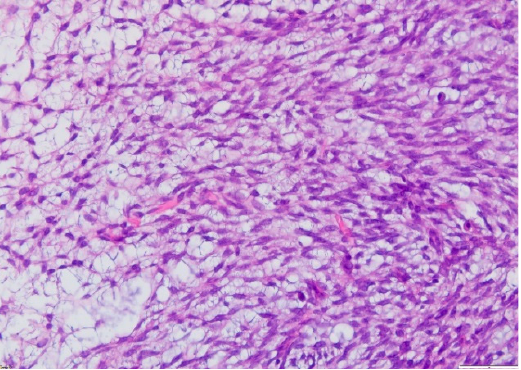
Figure 9. Microscopic finding—monophasic subtype of a synovial sarcoma with mesenchymal spin- dle cell elements and fusocellular proliferation (HE staining, 40×).